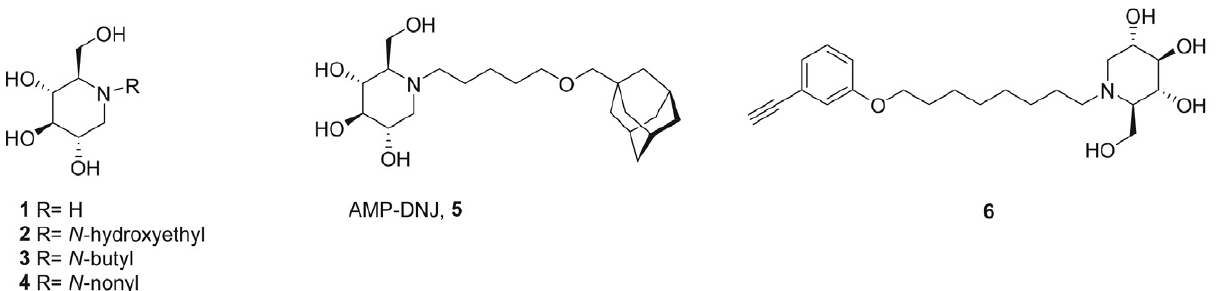
Figure 1. Known potent glycosidase inhibitors derived from